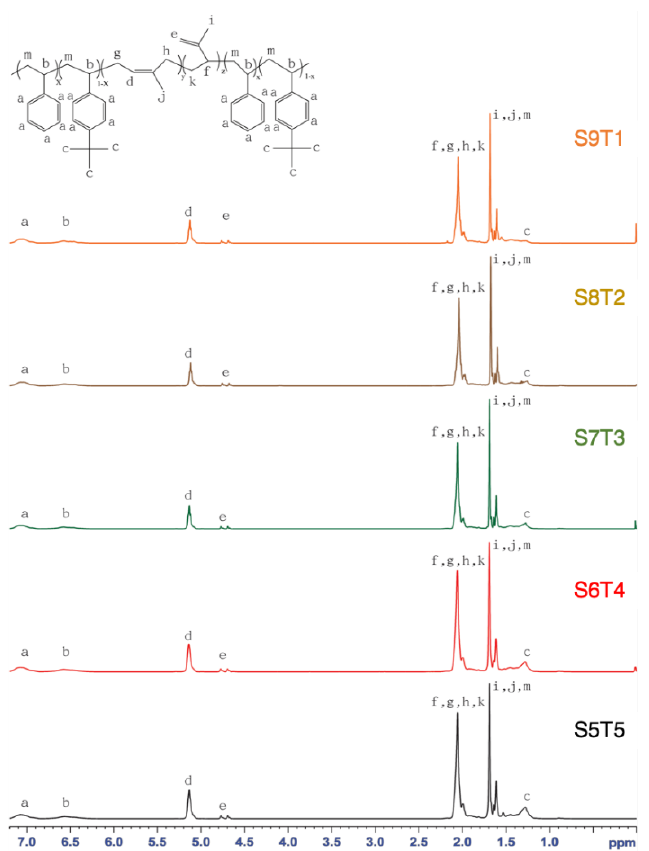
Figure 1. 1 H-NMR spectra of styrene–isoprene–styrene (SIS) triblock copolymers of different feed ratios.